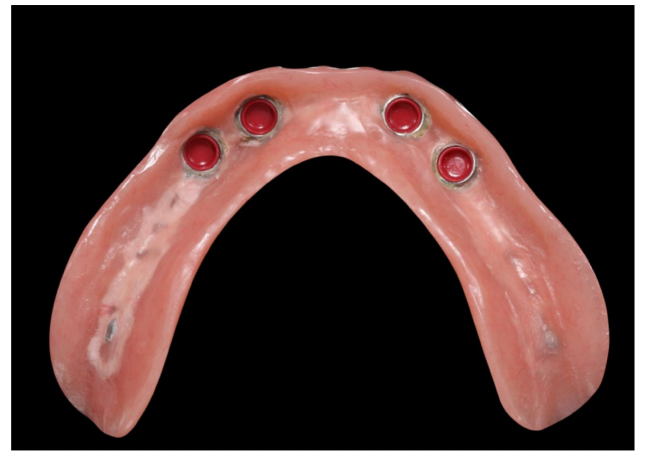
Figure 17. Basal view of the implant-supported overdenture in the lower jaw and its supporting framework equipped with intermediate retention inserts.